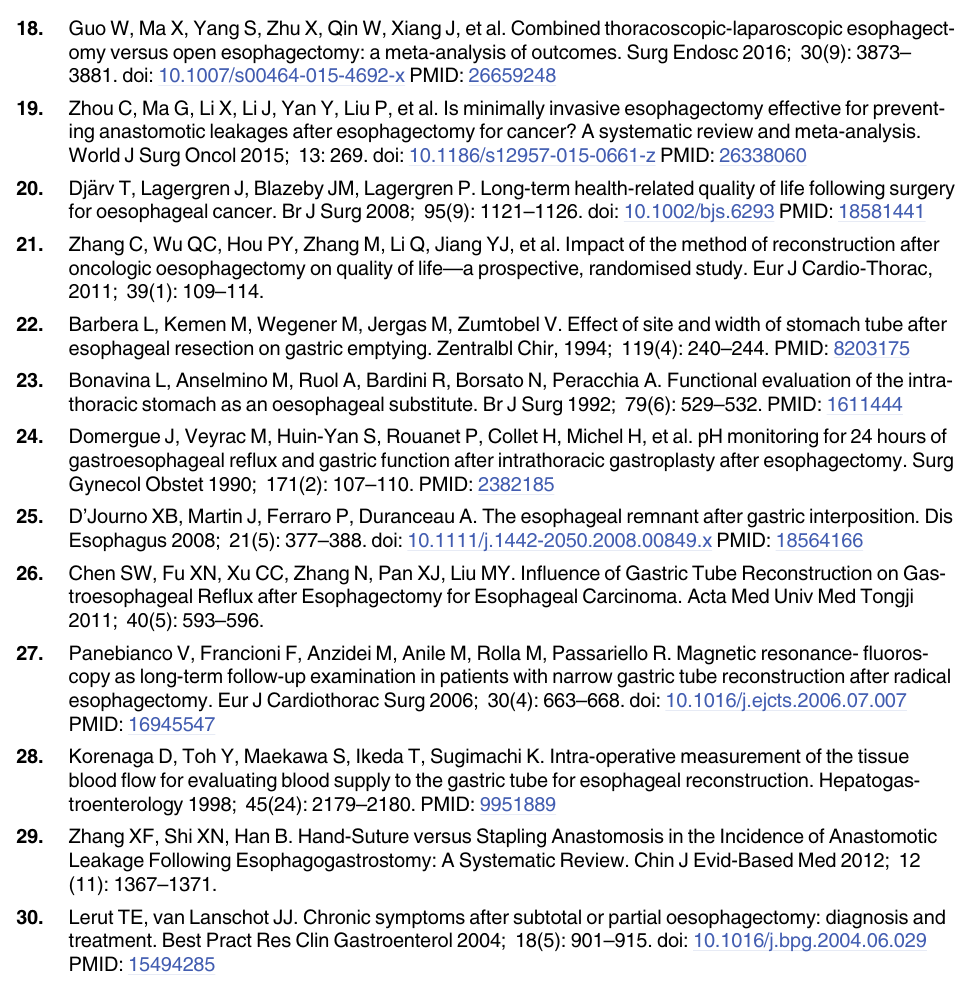
PLOS ONE | DOI:10.1371/journal.pone.0173416 March 7,